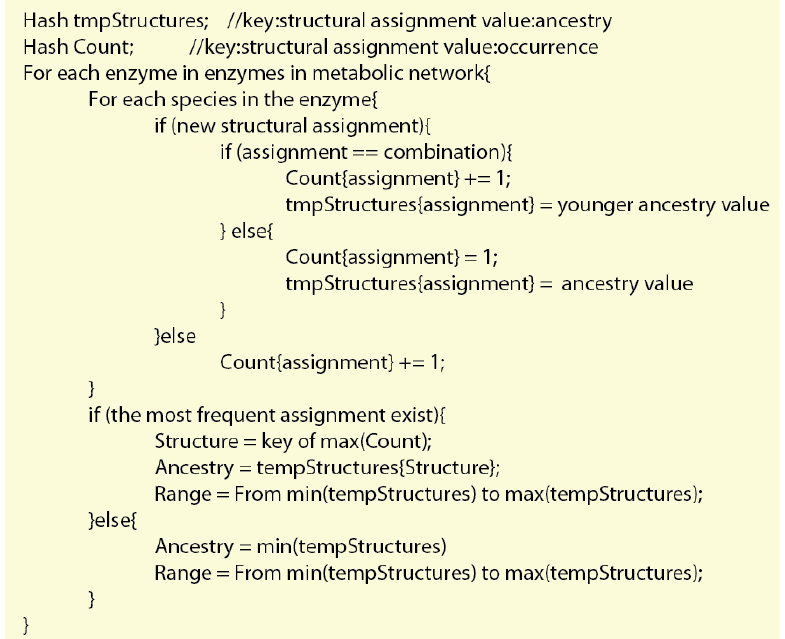
Figure 1: Pseudocode for the calculation of the most plausible ancestry of an enzyme. The algorithm assumes that the most important mechanisms of protein evolution involve duplication, amplification, mutational change, and recombination of genes and that these processes result in gradual buildup of new structures in protein architectures. Consequently, a domain combination in an enzyme that harbors multiple F structures probably arose by either an older structure recruiting a younger structure or vice versa. In both cases, the recruitment had to occur once the younger F structure appeared in evolution and the ancestry of the combination must be the ancestry of the youngest F. Using the algorithm we constructed a table that describes each individual enzyme, number of species analyzed, assignment of structures to enzymes in all organisms, a range of ancestry values derived from these assignments, and the most plausible enzymatic ancestry